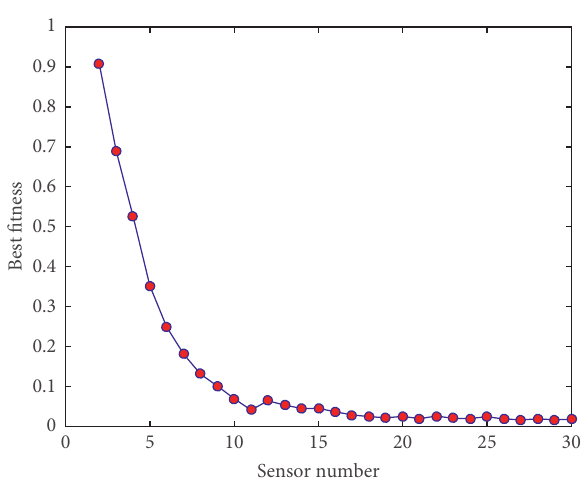
Figure 7: Curve of sensor number. Table 3: Calculation results based on response of cable-stayed